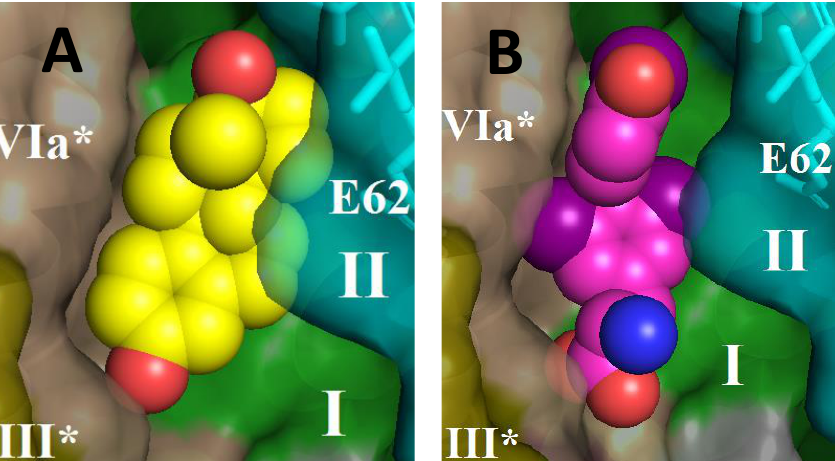
Figure 8. Proposed interaction of estradiol ( A ) and triiodo-thyronine ( B ) molecules with CcO in BABS. The structure of the dimeric enzyme in the region of BABS is shown. Side view: the inner (matrix) surface of the membrane is at the bottom. The ligand molecule is docked in a hydrophobic cavity near the entrance to the proton channel K. Subunits I (green) and II (cyan) are shown, as well as subunits III (brown) and VIa (wheat) from the neighboring monomer (marked with an asterisk). The indicated residue E62 from subunit II is located just on the border of the matrix and the entrance to the K-channel.